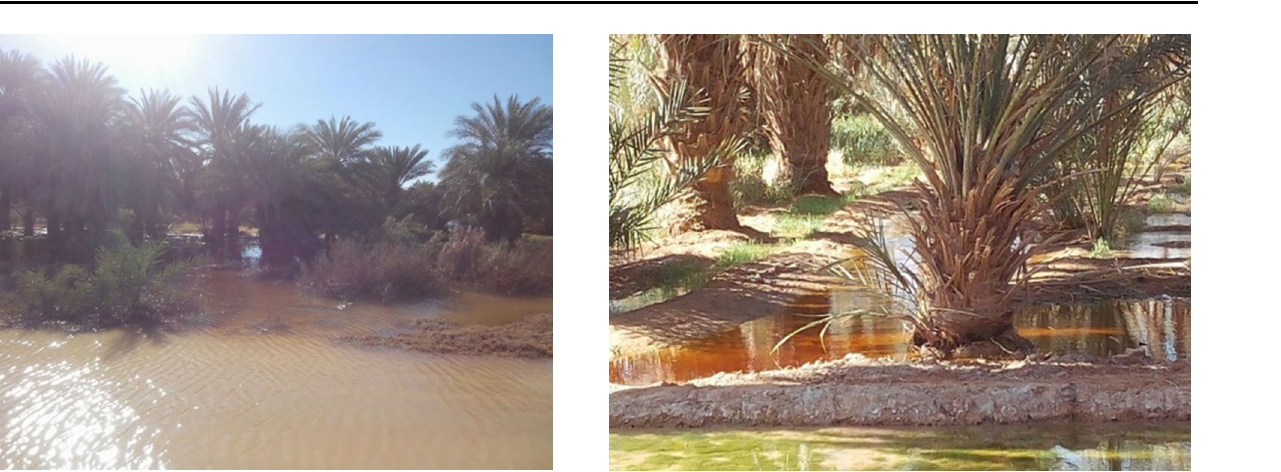
Fig. 17 Flooding of the Adouche palm groves. (photo. Authors 2018)